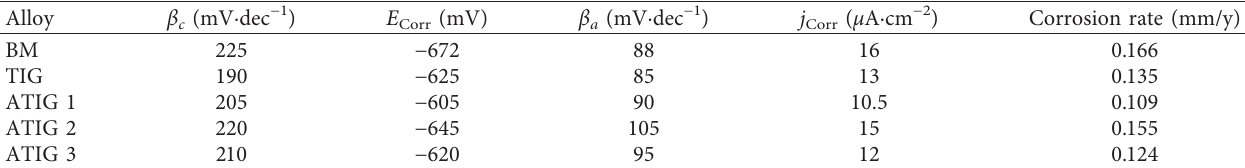
Figure 11: Potentiodynamic polarization curves obtained for BM, ATIG 1, ATIG 2, ATIG 3, and TIG samples after their immersion for 1h in 3.5% NaCl solutions. Table 15: Potentiodynamic polarization data obtained for BM, TIG, ATIG 1, ATIG 2, and ATIG 3 after 1h immersion in 3.5% NaCl